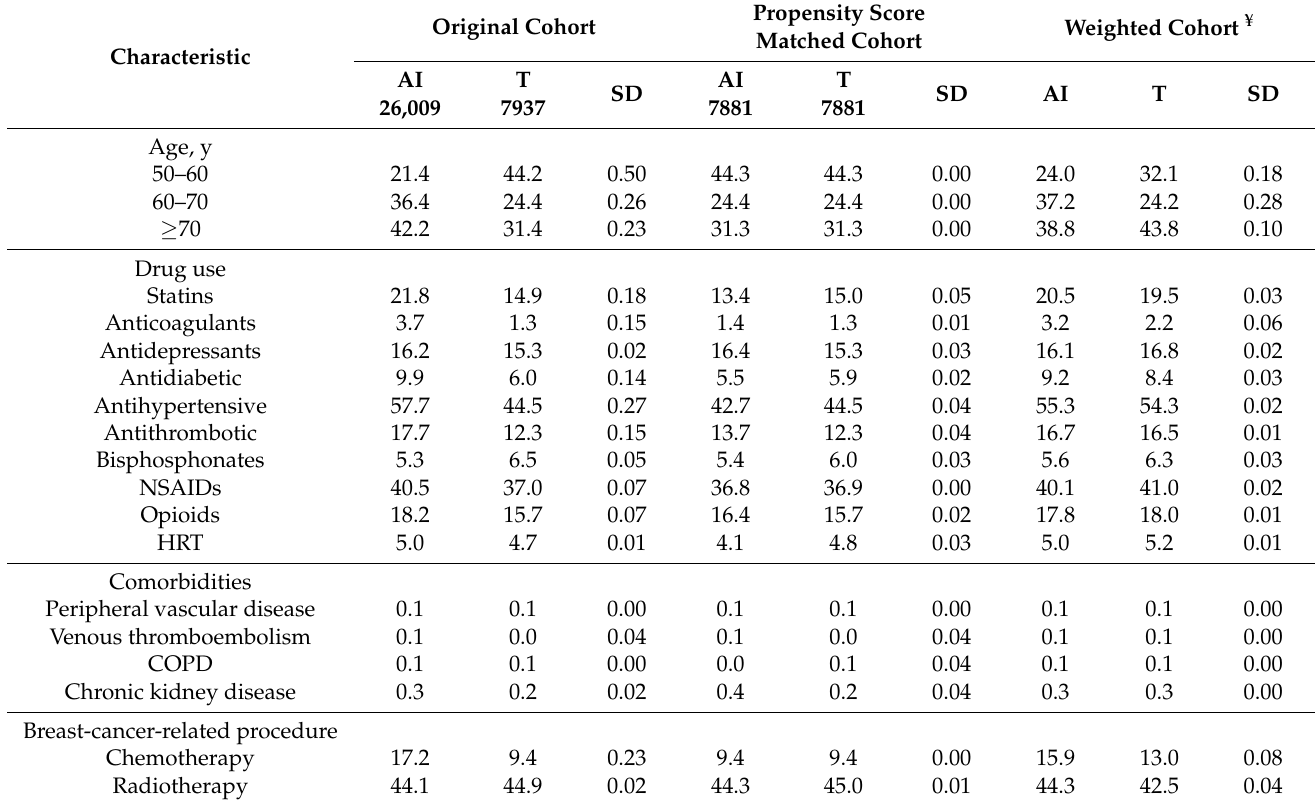
Table 1. Baseline characteristics (%) of the study cohort.